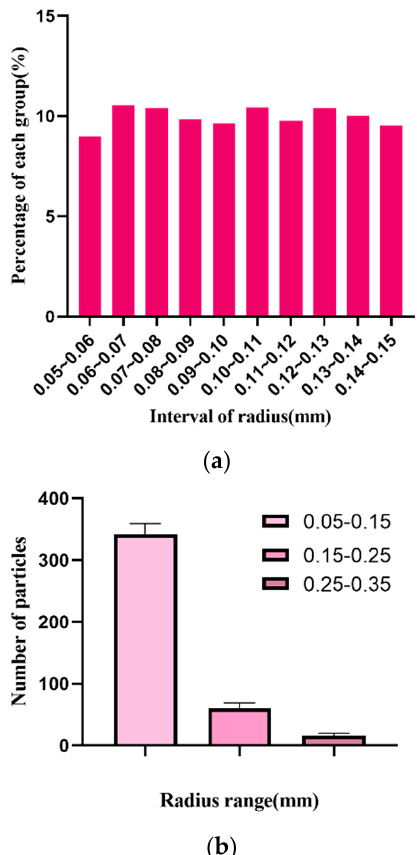
Figure 5. Distribution of particle radius in each interval. ( a ) Percentage of particles in each radius, ( b ) The number and standard deviation of particles within each radius.